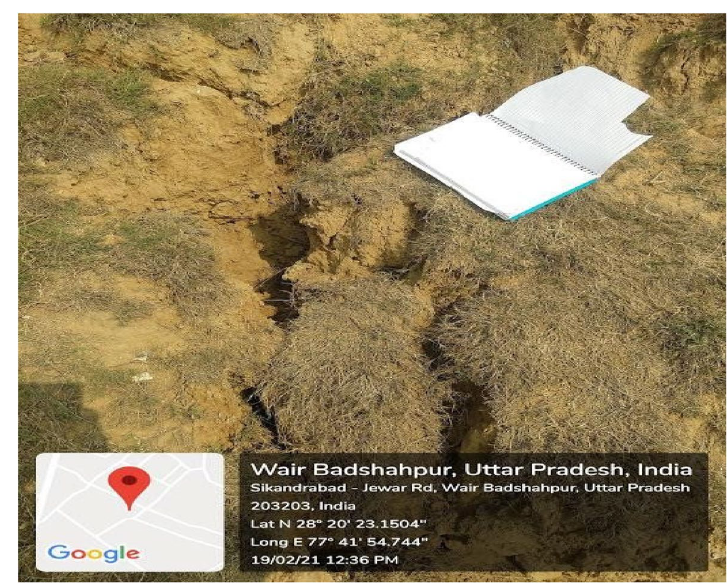
Fig. 6 Studied embankment at Wair, showing effect of gullying and slope failure no 4